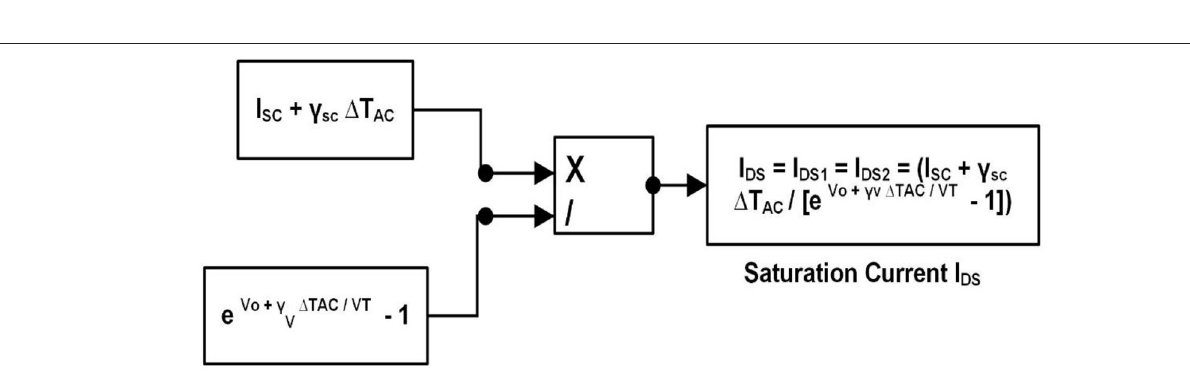
FIGURE 4 | Complete sub-system model of proposed two-diode photovoltaic (PV) model.